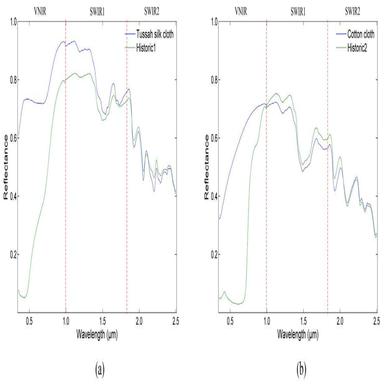
Reflectance spectral comparison between dyed and undyed textile samples.